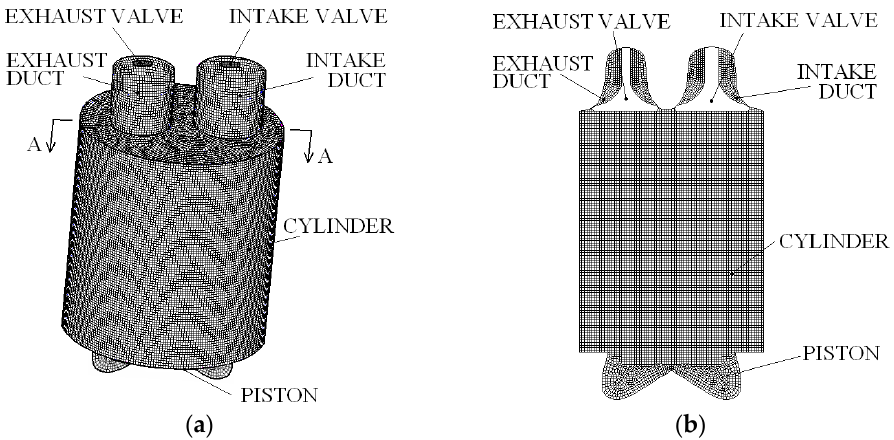
Figure 1. Computational mesh at bottom dead center. ( a ) Tri-dimensional view; ( b ) A-A section. The CFD simulations were carried out through the open software OpenFOAM. As diesel combustion, ammonia combustion, and NO x reduction schemes, the models of Ra and Reitz [16], Mathieu and Peterson [17], and Miller and Glarborg [18] were employed, respectively. The fuel heat-up and evaporation were treated through the Dukowicz [19] model and the fuel droplet breakup through the Kelvin-Helmoltz and Rayleigh-Taylor [20] model. The CFD model is based on the equations of conservation of mass, momentum, and energy, Equations (1)–(3),